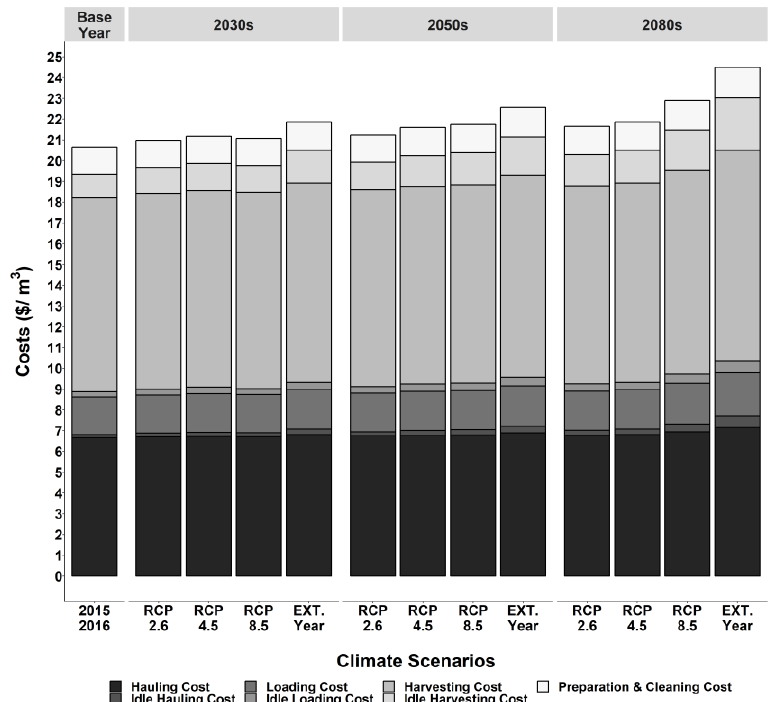
Figure 2. Total costs of logging operations (winter and summer) where the harvested wood is hauled only to the mill yard under the current climate and several future times with three different climate radiative forcing values, using the HadGEM2-ES climate model. The extreme year (EXT Year) has the warmest winter in any of the RCP values of a time interval. Calculations subtracted Sundays and holidays from time available for